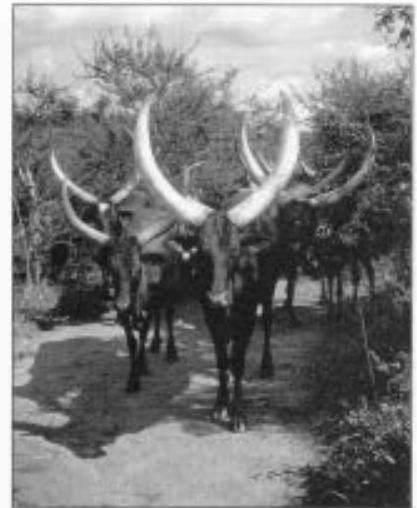
Figure 1 Long-horned Ankole cattle near Ntusi, southwestern Uganda.